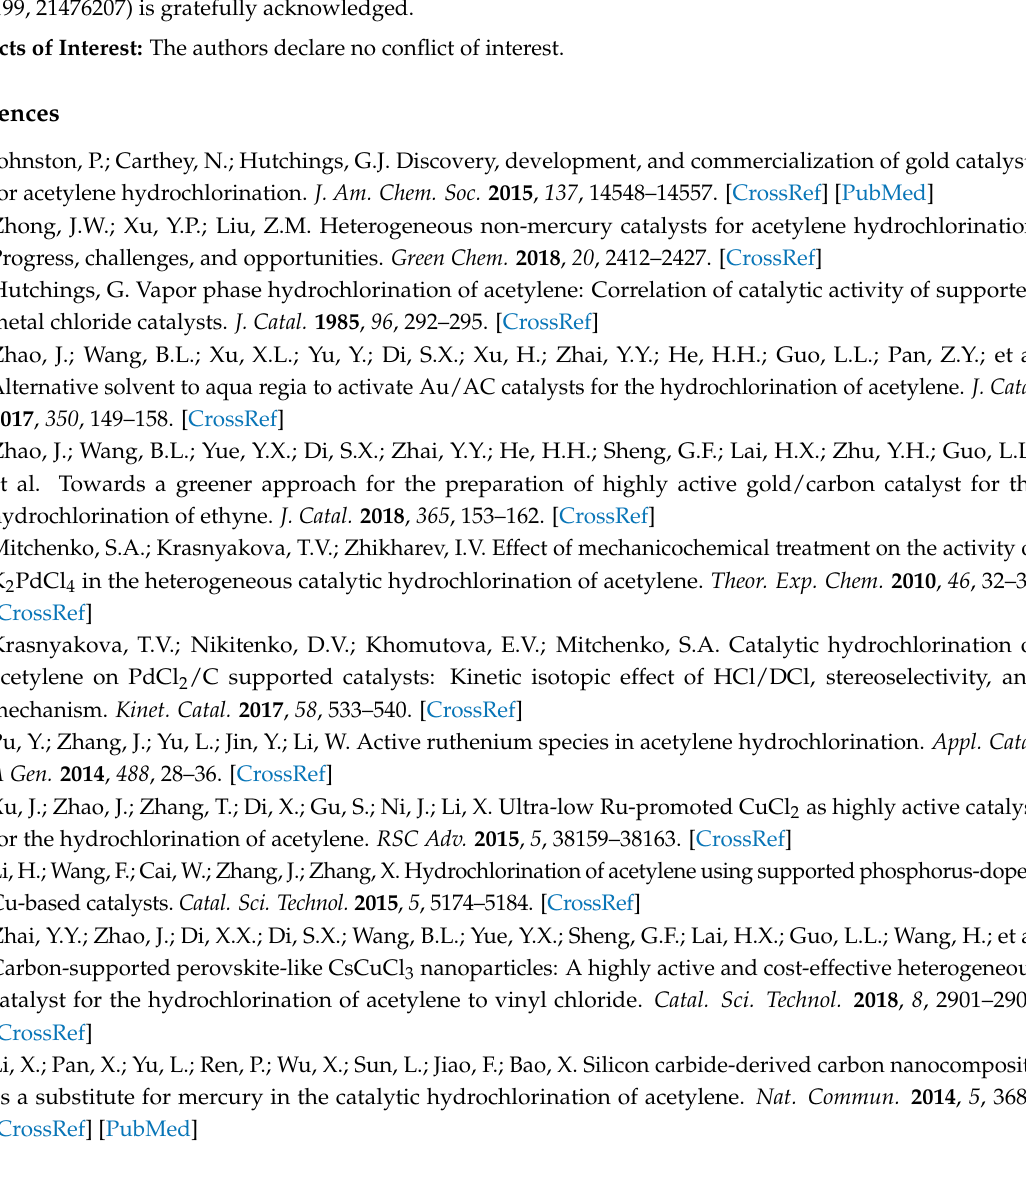
Figure S1: XRD patterns of CaX as a function of the amount of Ca loading: (a) CaX, (b) CaX-1.46 wt % Ca, (c) CaX-3.11 wt % Ca, (d) CaX-5.19 wt % Ca, (e) CaX-8.04 wt % Ca, Figure S2: The decomposition temperature of [Emim][BF4] with different amount of supporting IL, Figure S3: Space-time yields of VCM with different supporting ILs catalysts, Figure S4: Catalytic performance as functions of different GHSV (C 2 H 2 ) for IL/CaX. Reaction conditions: 320 ◦ C; V(HCl)/V(C 2 H 2 ) = 1.2, Figure S5: TPD-MS profiles of HCl and C 2 H 2 on the fresh and used IL/CaX